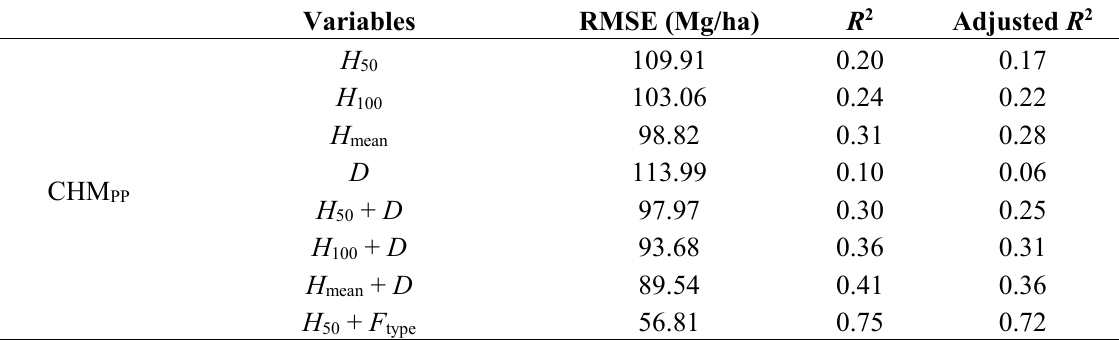
Table 3. Results of estimation models each of canopy height model using canopy height model (CHM) PP and CHM PL